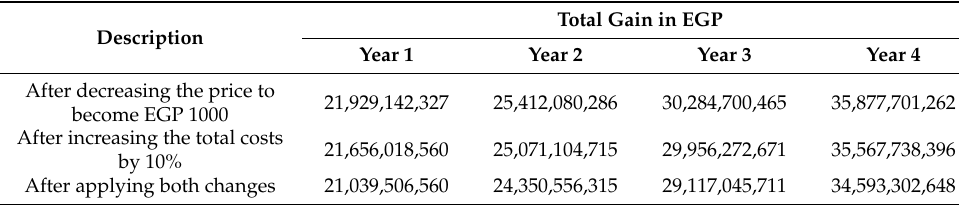
Table 9. Sensitivity